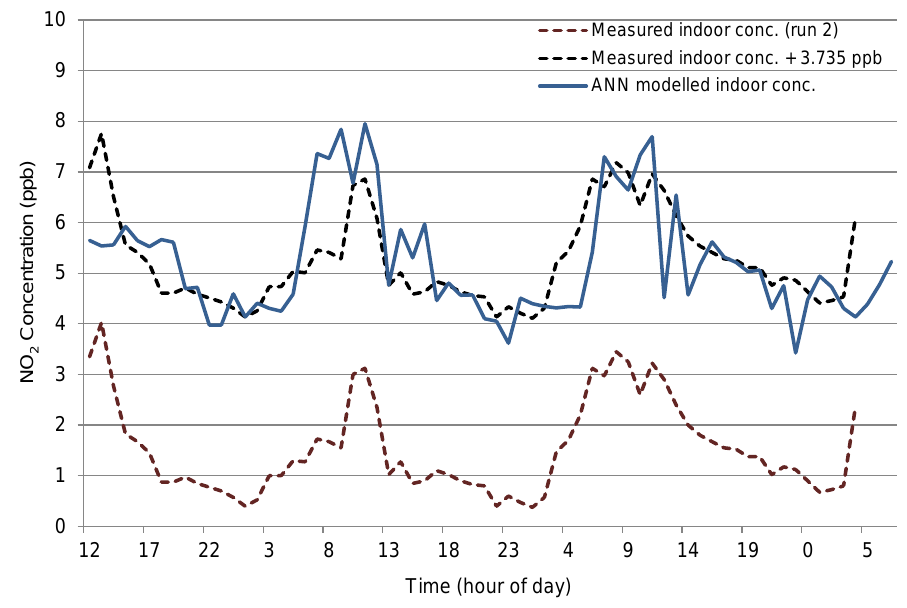
Figure 8. Measured versus modelled indoor NO 2 concentrations at N t 2 (run 2).